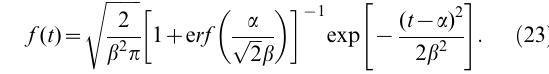
z 3 c c ~ c 3 v . Thus the curves depicted in Fig. 3 and Fig. 4 would v retain their unimodal shapes if plotted in dependence on c .